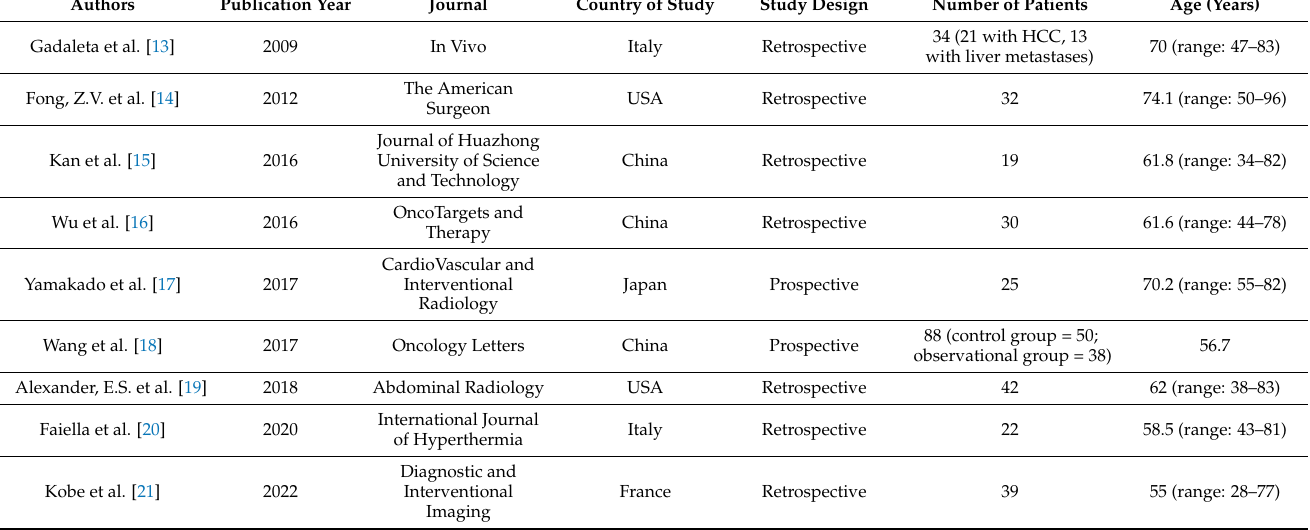
Table 1. Characteristics of the studies included in the review (part 1).